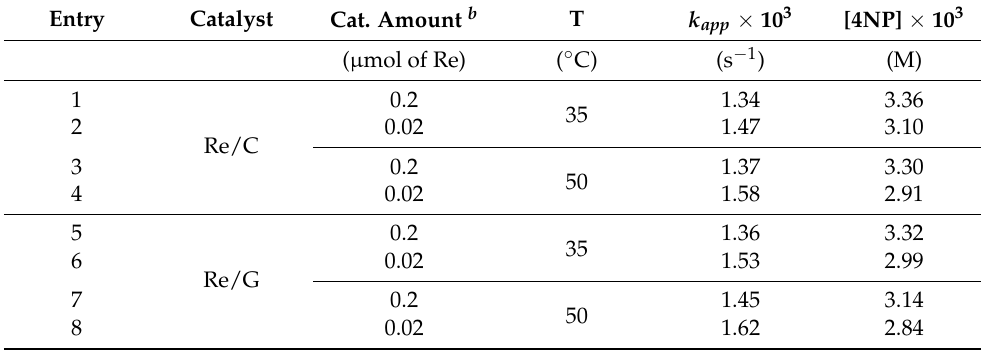
Table 1. Catalytic performance a of Re/C and Re/G as a function of catalyst amount and